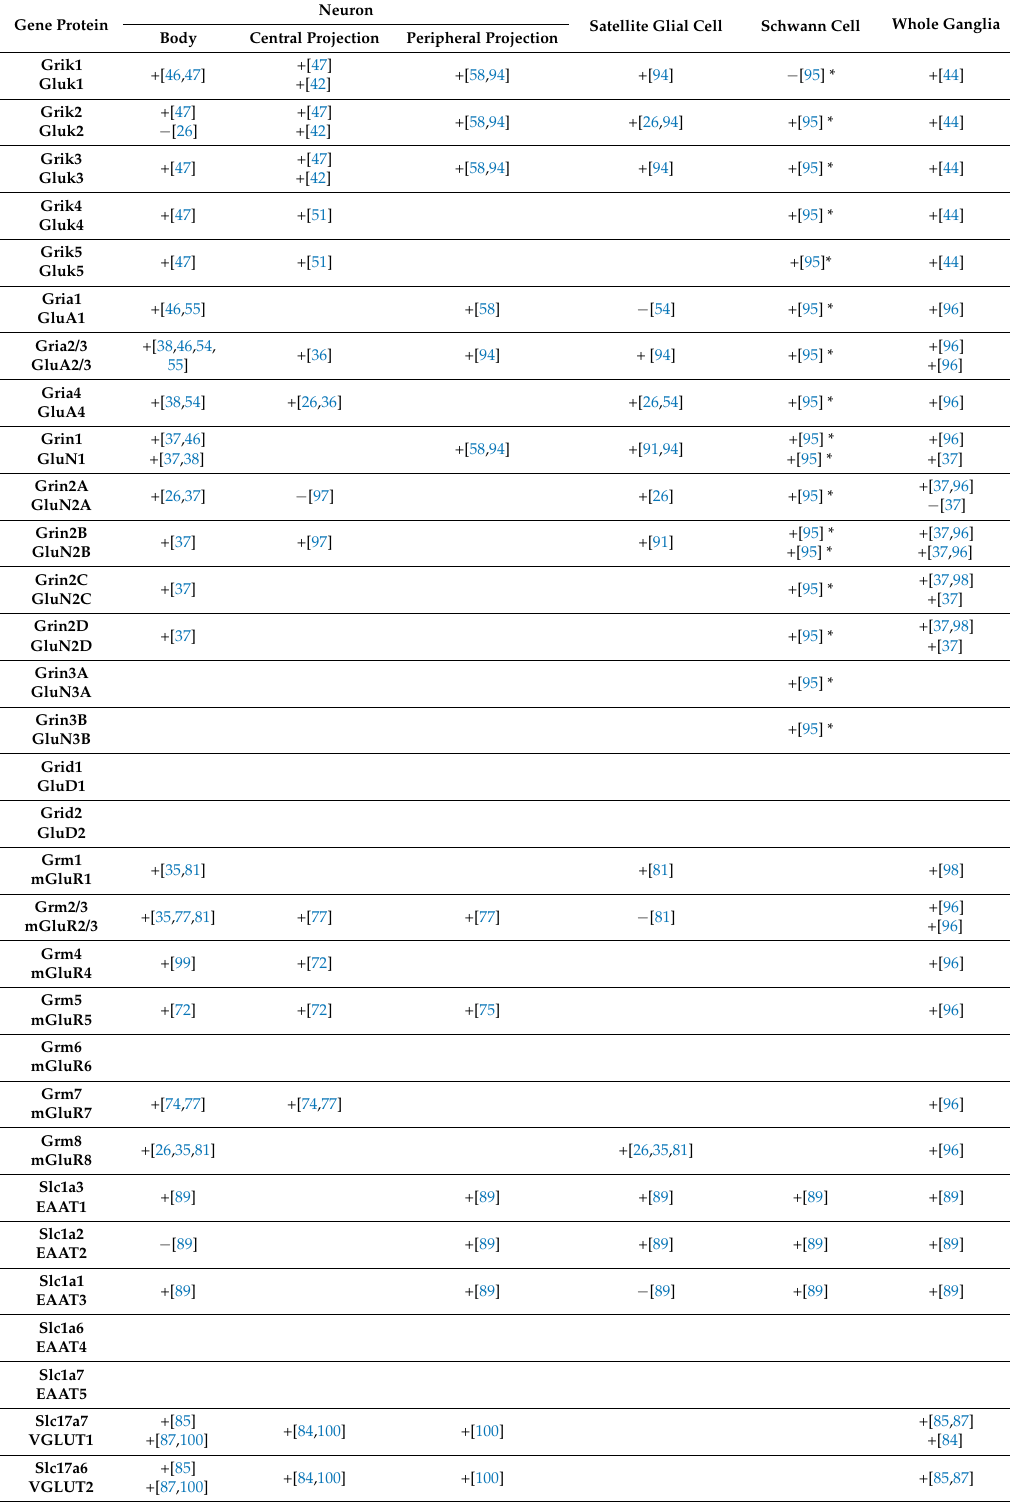
Table 1. Summary of the glutamate-related genes and proteins that are expressed in DRG and/or TG neurons and glial